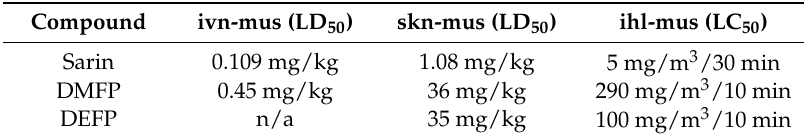
Table 1. Toxicity data for dimethyl fluorophosphate (DMFP) and diethyl fluorophosphate (DEFP) compared to the nerve agent sarin (mus = mouse; ivn = intravenous, skn = skin; ihl = inhalation; n/a = not available).